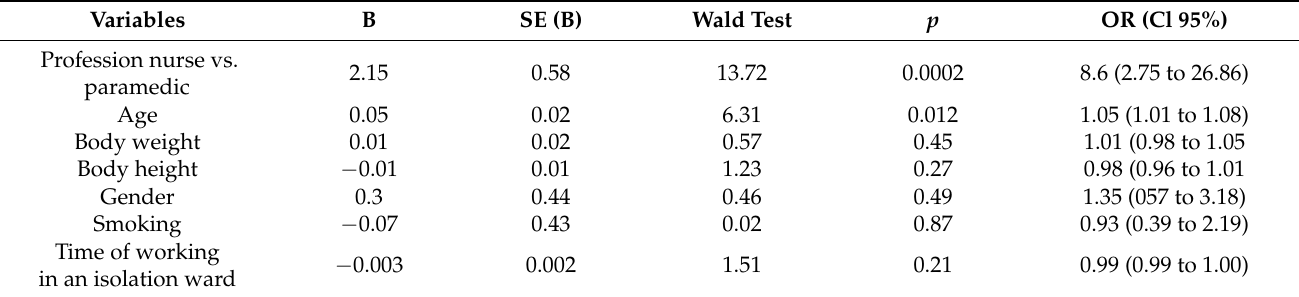
Table 4. Univariate logistic regression analysis results assessing variables for the physical symptoms (n =